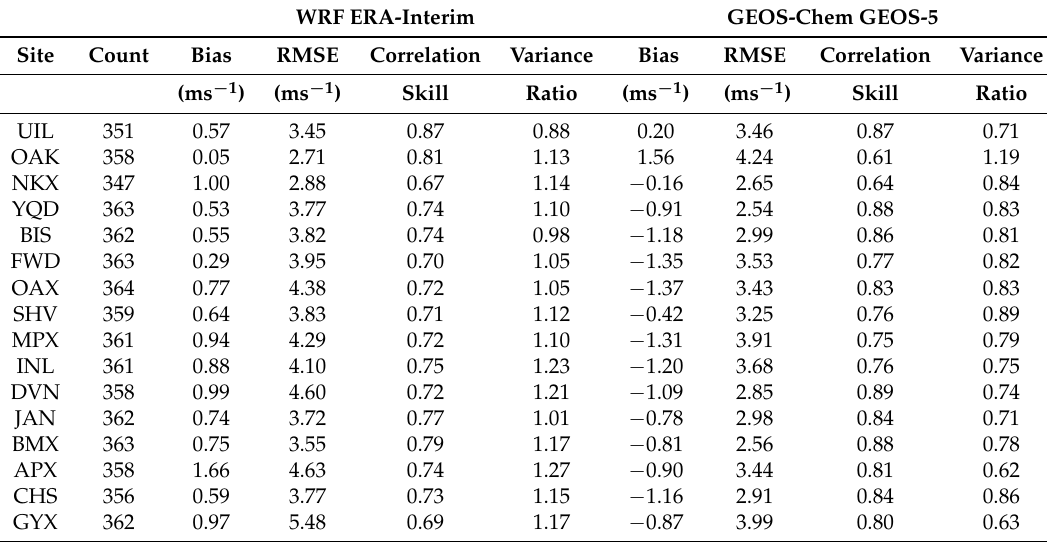
Table A1. Model comparison to rawinsonde wind speed at mandatory reporting level 850 hPa, 00 UTC in 2010.